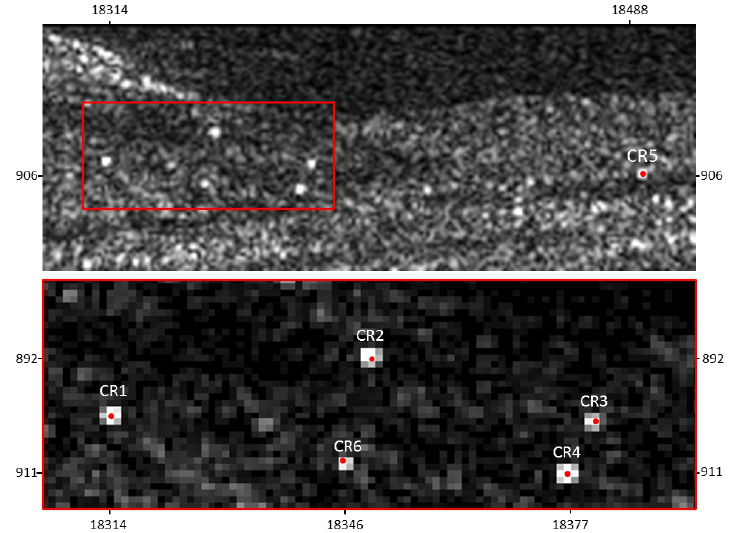
Figure 9. Sentinel-1 intensity image (2017/09/30) in radar Doppler geometry centered on six CRs installed over a surrounding moraine of the Argentière glacier. Red points: selected pixels, red rectangle: zoom on the five closest